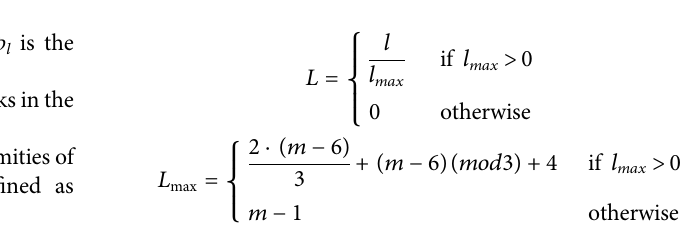
Frontiers in Robotics and AI |